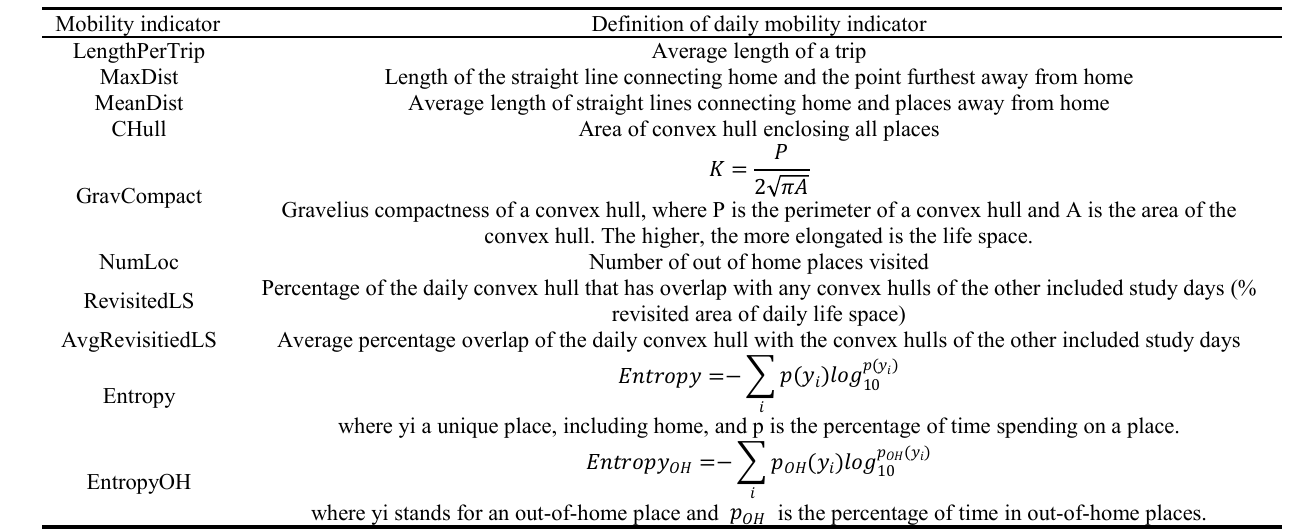
Table 1. Description of the computation of the selected basic